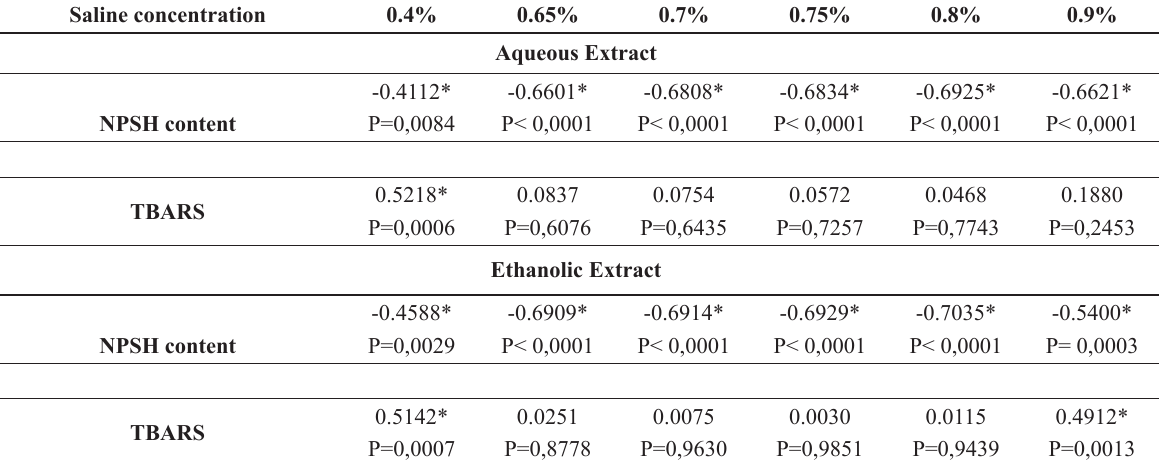
Pearson correlations between saline concentration and NPSH or TBARS content. Saline